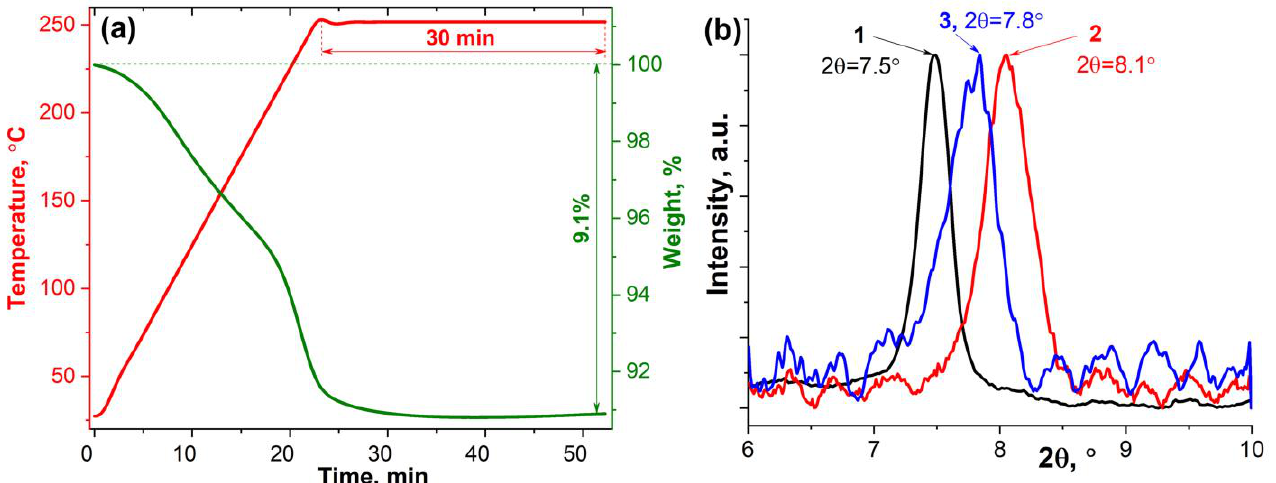
Figure 2. DSC (blue) and TGA (green) curves of Ti 2 CT x MXene obtained by thermal analysis in air flow ( a ) and argon ( b ).